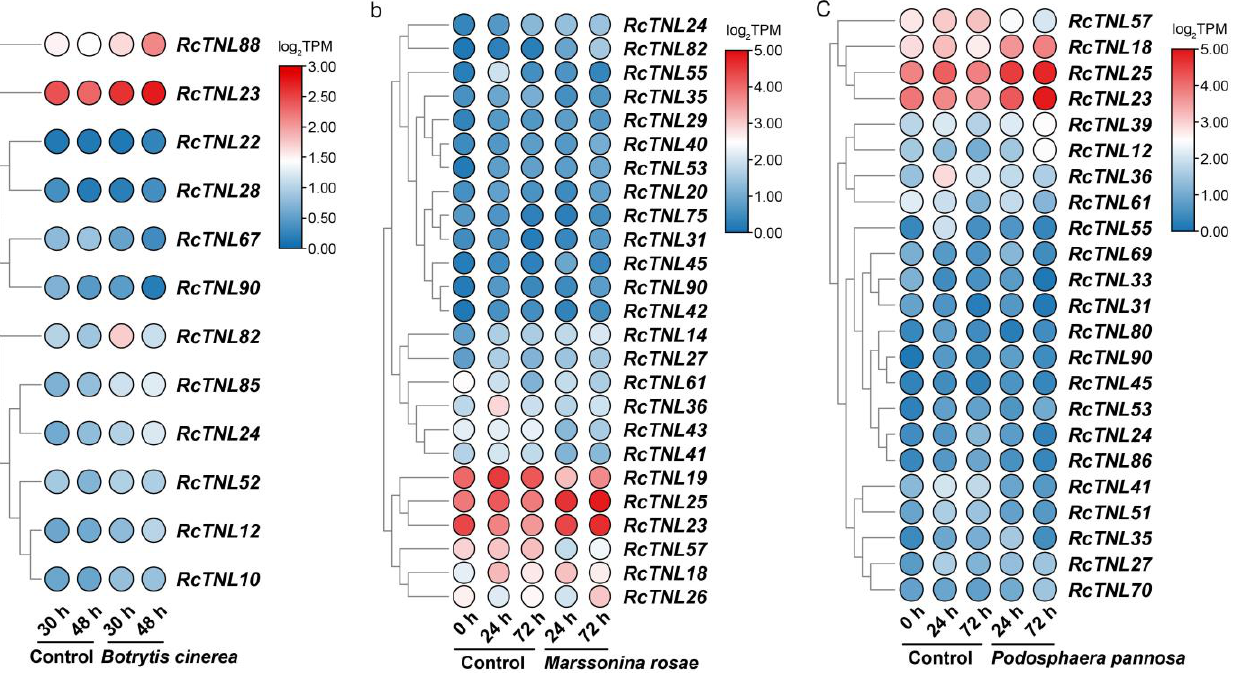
Figure 9. Expression pattern of RcTNL genes in response to fungal disease. ( a ) Heatmap of RcTNL genes differentially expressed in ‘ Samantha ’ petals during inoculation with Botrytis cinerea . ( b ) Heatmap of RcTNL genes differentially expressed in ‘ Pariser Charme ’ leaves during inoculation with Marssonina rosae . ( c ) Heatmap of RcTNL genes differentially expressed in ‘ Pariser Charme ’ leaves during inoculation with Podosphaera pannosa . The change in color of the circles from blue to red indicates a change in the log 2 TPM values from low to high.